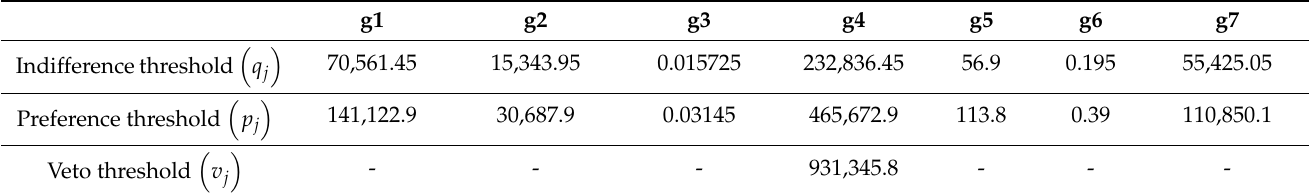
Table 21. Values of thresholds and veto on operating cost